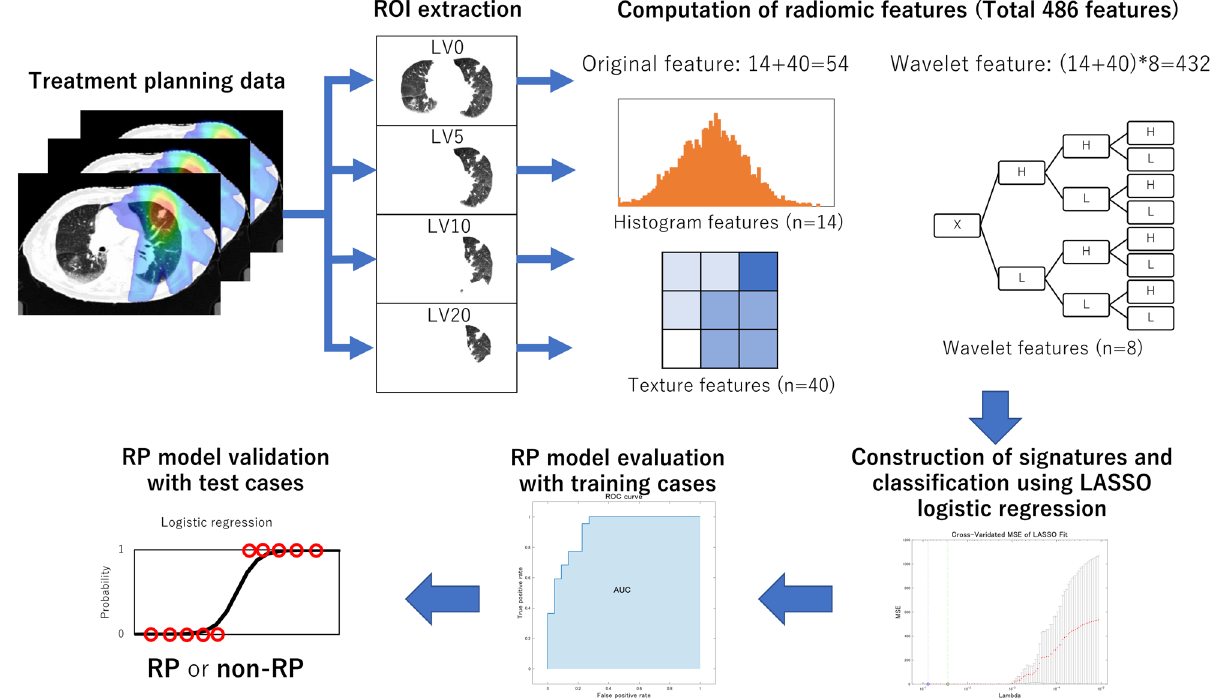
Figure 1. An overall workflow of the proposed scheme for RP